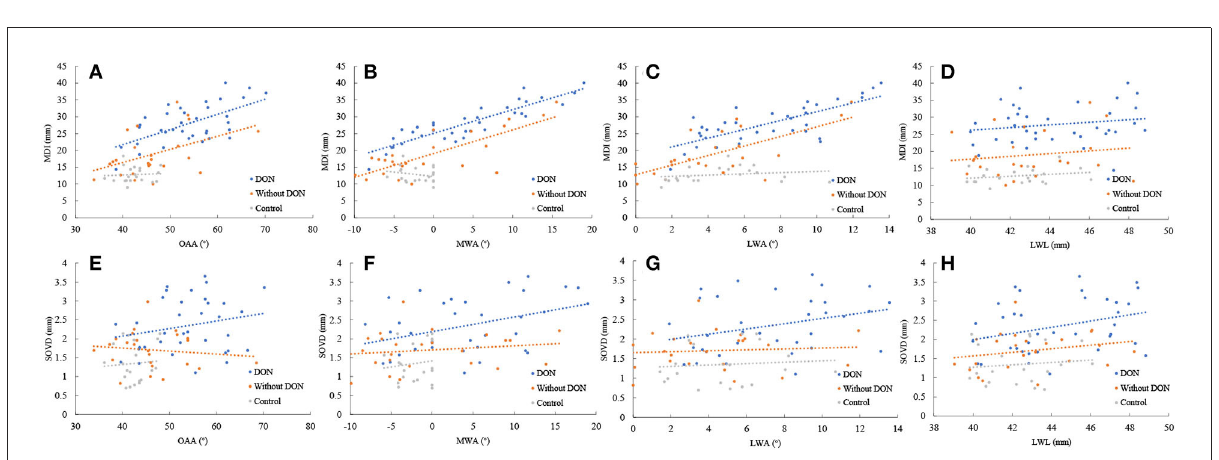
FIGURE3 Relationship between the MDI and SOVD with the OAA (A,E) , the MWA (B,F) , the LWA (C,G) , and the LWL (D,H) in the orbits with and without DON groups and control group.